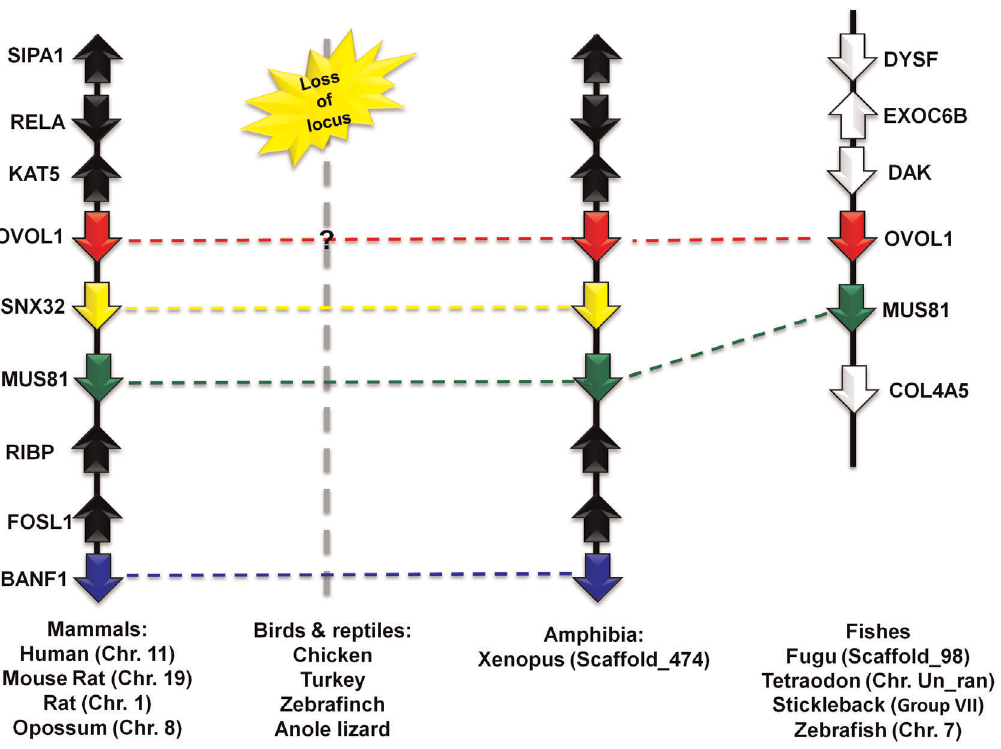
Figure 3. Chromosomal localization of OVOL1 gene from selected vertebrates, flanked by a set of conserved marker genes. SIPA1: signal-induced proliferation-associated 1; RELA: v-rel reticuloendotheliosis viral oncogene homolog A (avian); KAT5: K (lysine) acetyltransferase; SNX32: sorting nexin 32; MUS81: MUS81 endonuclease homolog ( S. cerevisiae ); BANF1: barrier to autointegration factor 1; EXOC6B: exocyst complex component 6B; DYSF: dysferlin, limb girdle muscular dystrophy 2B; COL4A5: collagen, type IV, alpha 5; DAK: dihydroxyacetone kinase 2 S. cerevisiae